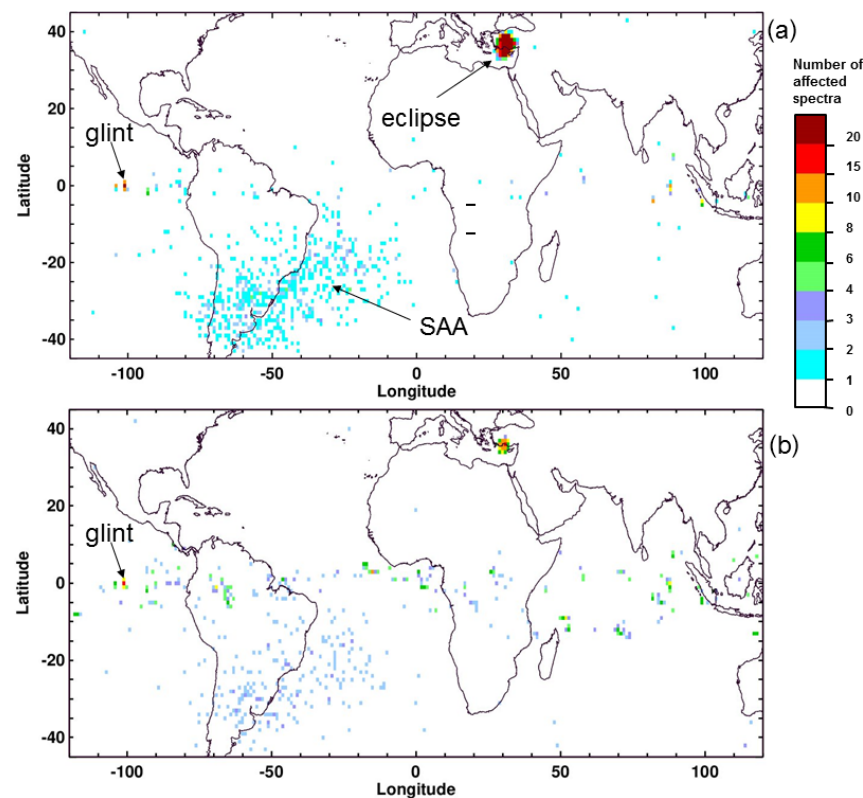
Figure 8. Gridded (1 ◦ × 1 ◦ ) distributions of the number of affected spectra for March 2006; (a) vis of 424.1–434.5nm, DI > 0.03; (b) vis of 445.3–455.7nm, DI > 0.25. The South Atlantic Anomaly and a region affected by solar eclipse are clearly visible; the remaining pixels with high DI values are mostly associated with sunglint and bright